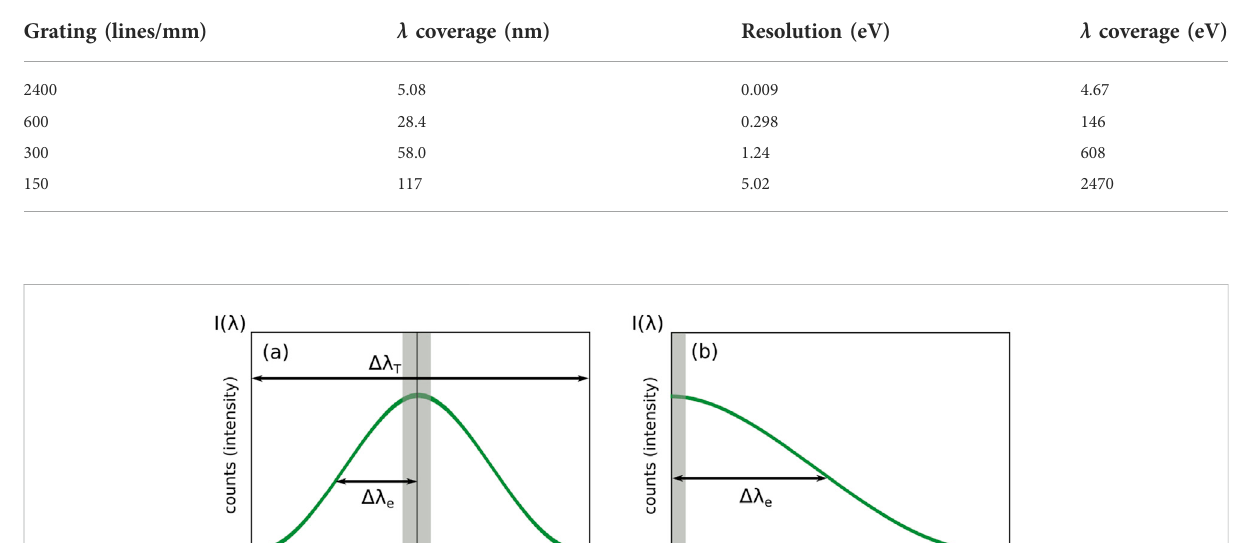
TABLE 2 Accessible electron energies and detection resolution based on choice of spectrometer grating.